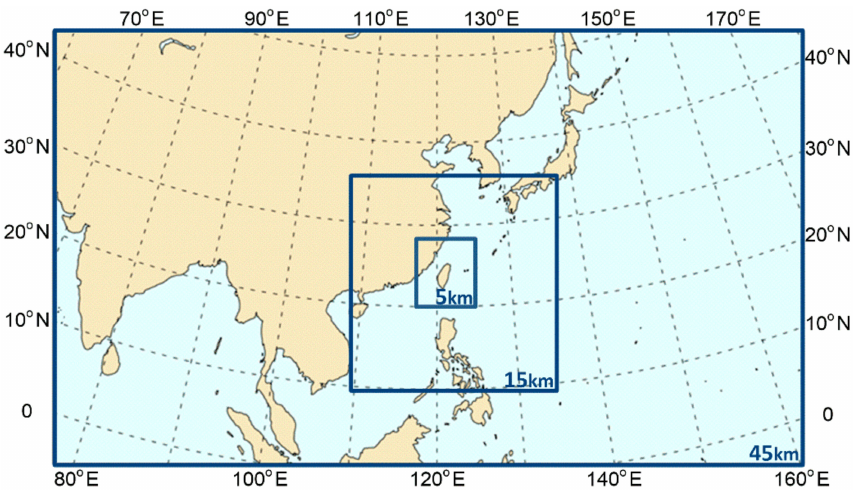
Figure 1. Three nested domains used in